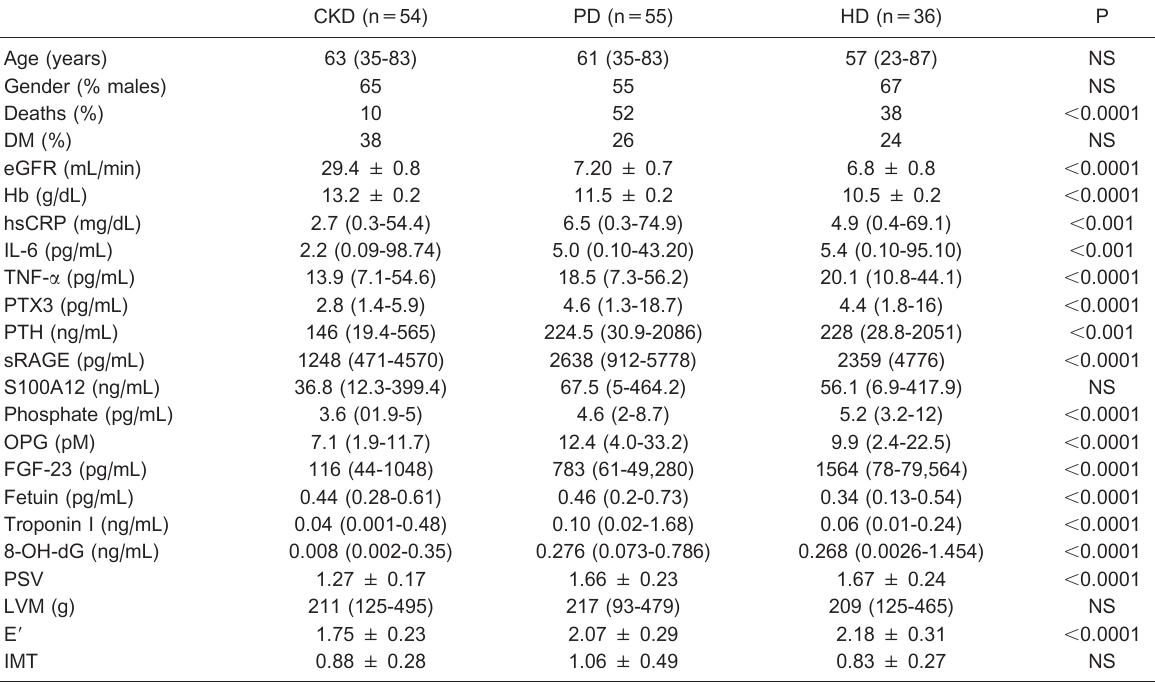
Table 1. Clinical and biochemical characteristics of the